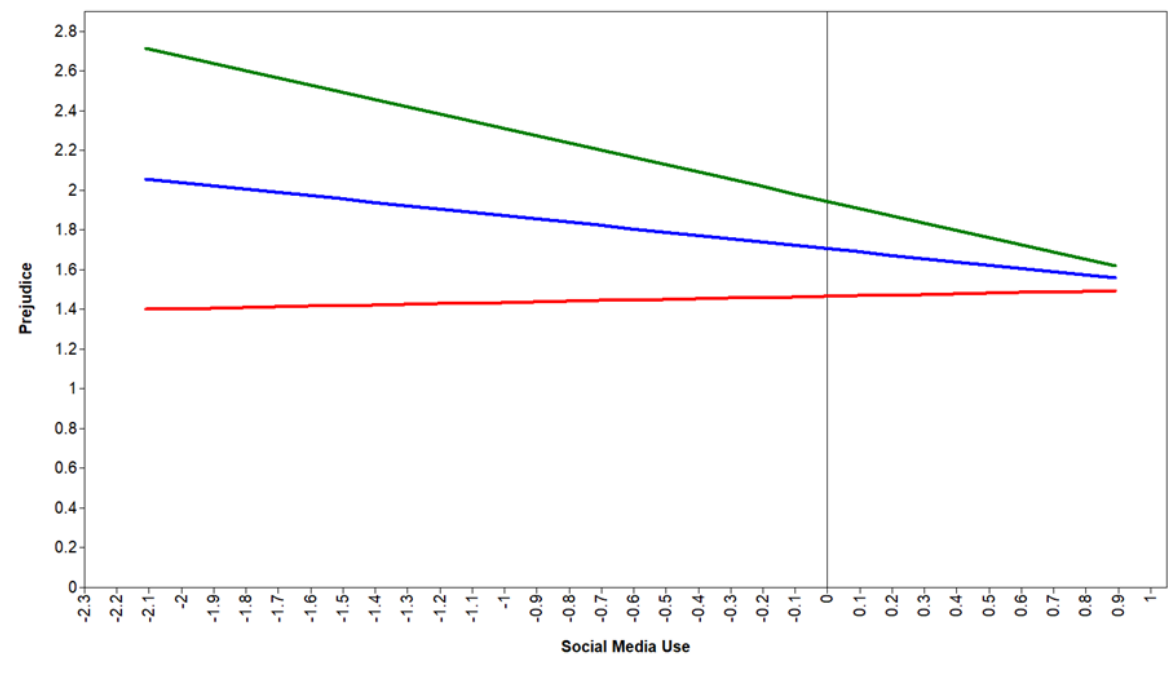
Figure 1. Interaction plot showing predicted values of prejudicial attitudes toward Asians as a function of social media use and trust in social